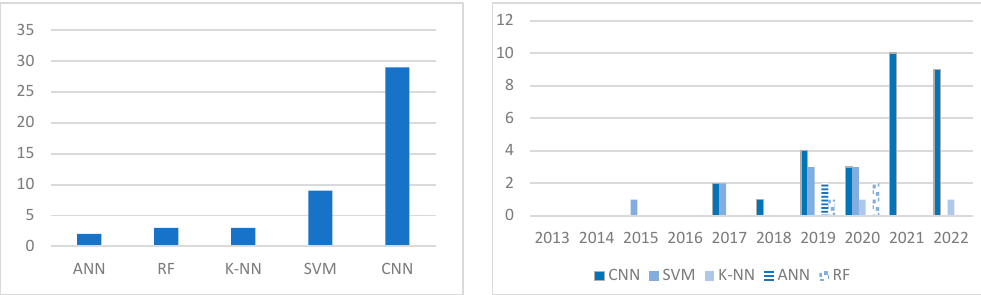
Figure 3. ( Left ) Most used models. ( Right ) Most used models over the years.